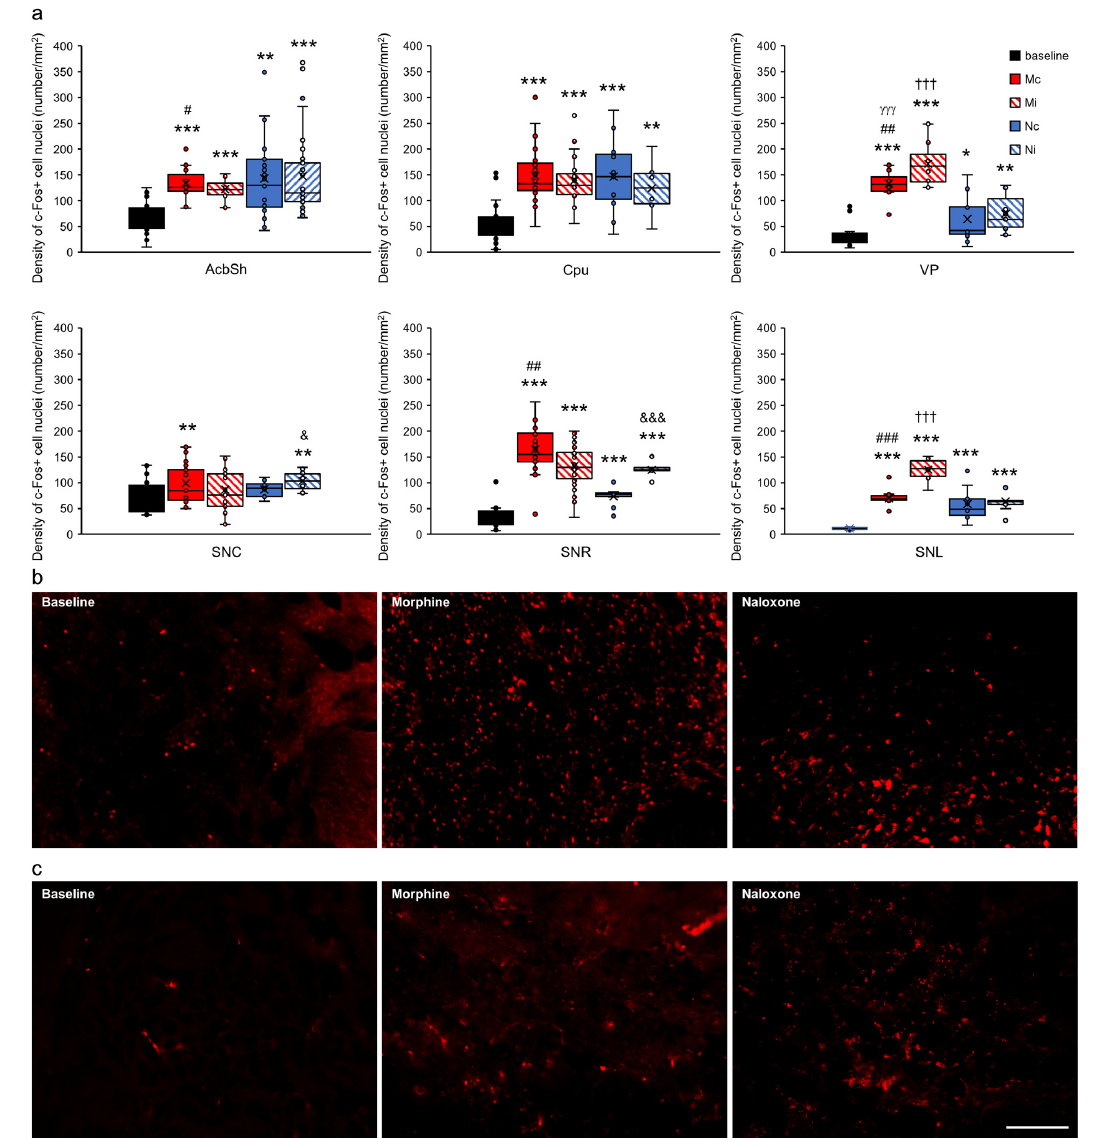
Figure 12. Density of c-Fos+ cell nuclei (number/1 mm 2 ) in select extrapyramidal structures and ventral striatum in the brains of rats that were subjected to VTA electrical stimulation (Es-VTA) only (baseline group, n = 5) (black-filled bars) and in the brains of rats administered Es-VTA and a one-time injection of morphine (1.5 µ g) or naloxone (25.0 µ g) injected into the PPN in the contralateral (Mc, n = 5, red-filled bars; Nc, n = 6, blue-filled bars) and ipsilateral hemispheres (Mi, n = 5, red-hatched bars; Ni, n = 6, blue-hatched bars) ( a ). Representative photomicrographs of c-Fos-labeled neurons in the AcbSh ( b ) and Cpu ( c ) structures are shown. Scale bar = 100 µ m (white line: right lower corner of the last photo, panel ( c )). Tukey’s post hoc test: * p < 0.05, ** p < 0.01, and *** p < 0.001 indicate a significant difference between the baseline and other experimental groups (Mc, Mi, Nc, and Ni groups); # p < 0.05, ## p < 0.01, ### p < 0.001 indicate a significant difference in the morphine groups between different injection site: contra- or ipsilateral hemispheres (Mc vs. Mi group); γγγ p < 0.001 indicate a significant difference in the contralateral side groups between different injection drug: morphine or naloxone (Mc vs. Nc group); ††† p < 0.001 indicate a significant difference in the ipsilateral side groups between different injection drug: morphine or naloxone (Mi vs. Ni group); & p < 0.05, &&& p < 0.001 indicate a significant difference in the naloxone groups between different injection site: contra- or ipsilateral hemispheres (Mc vs. Mi